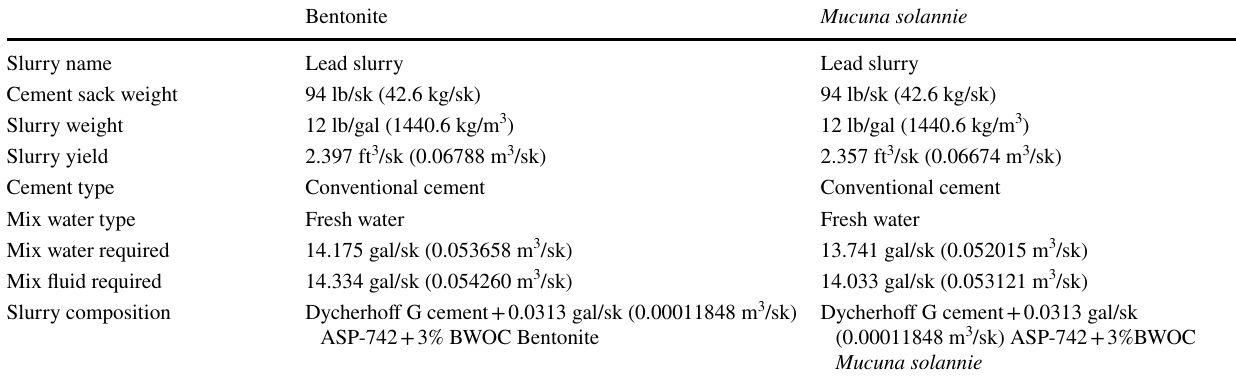
Table 2 Bentonite and Mucuna solannie extenders slurry